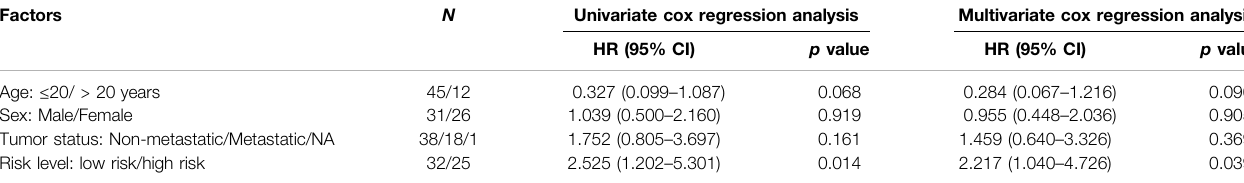
TABLE 3 | Univariate and multivariate cox regression analysis of clinical information for EWS patients in the validation